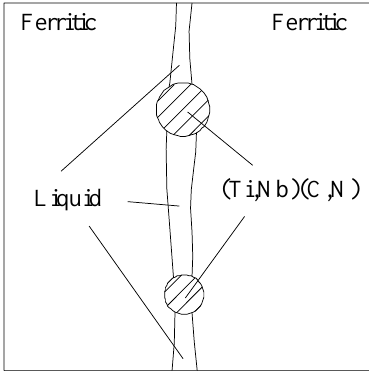
Figure 7. Phase-temperature equilibrium diagrams for ( a ) 441 and ( b ) 441Ce type ferritic stainless steel materials.